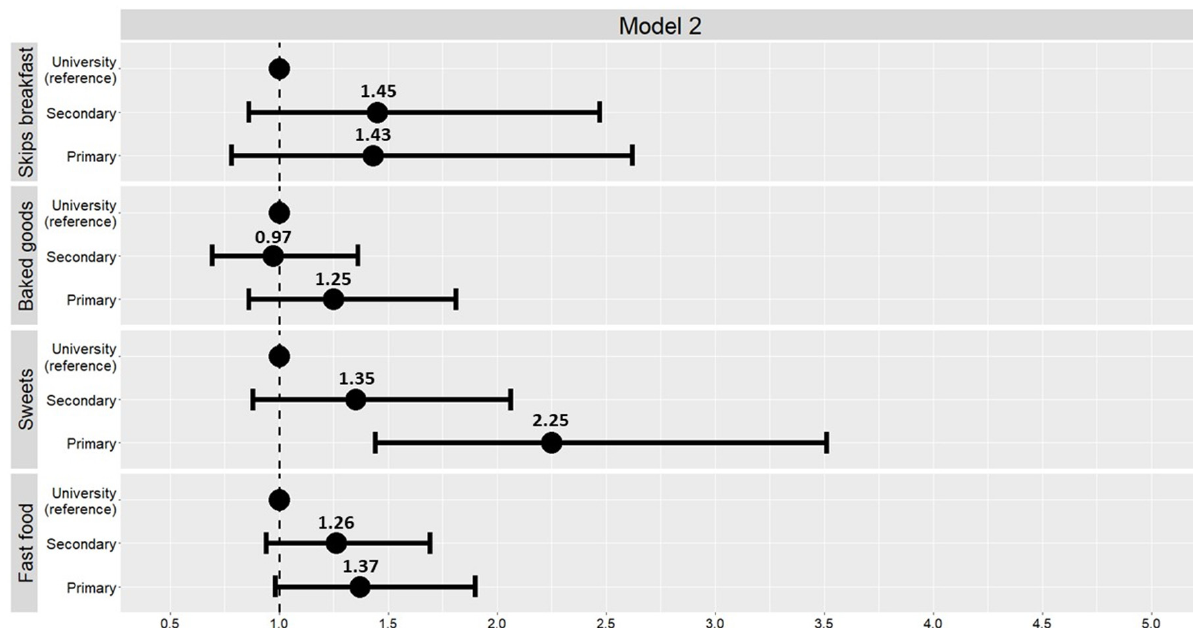
Figure 1. Association of maternal education with children’s having unhealthy dietary habits. Model 1. Multiple logistic regression models adjusted for sex, age, zBMI, municipality, school, and allocation to intervention or control group. Model 2. Multiple logistic regression models adjusted for sex, age, zBMI, municipality, school, allocation to intervention or control group, and the corresponding dietary behavior at baseline. Skips breakfast (no = 0, yes = 1), has commercially baked goods or pastries for breakfast (no = 0, yes = 1), takes sweets and candies several times every day (no = 0, yes = 1), goes more than once a week to a fast-food restaurant (no = 0, yes = 1).